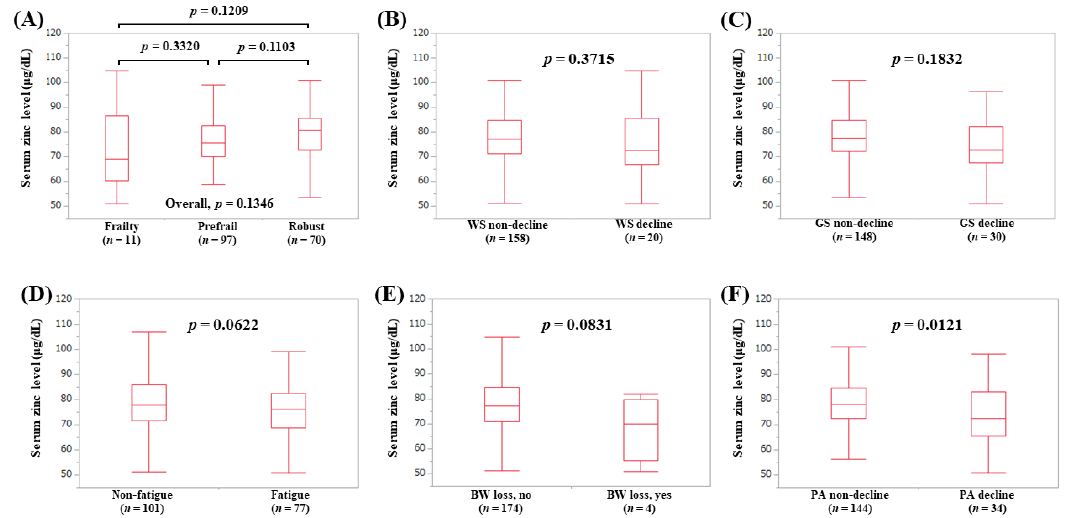
Figure 5. Serum Zn level according to the frailty status ( A ) and serum Zn level according to each frailty phenotype in non-LC patients: ( B ) walking speed, ( C ) grip strength, ( D ) fatigue, ( E ) body weight loss, ( F ) physical